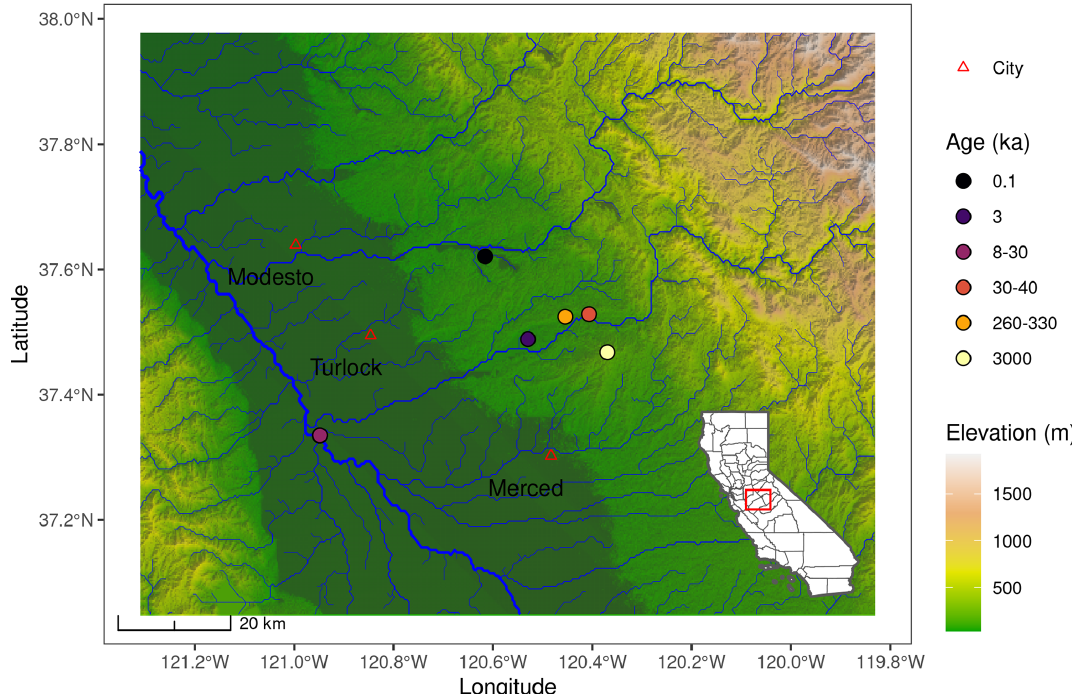
Figure 1. Map of the study area based on a digital elevation model (DEM) retrieved from Shuttle Radar Topography Mission (SRTM, resolution ∼ 30m). River hydrology data were taken from Lehner et al.